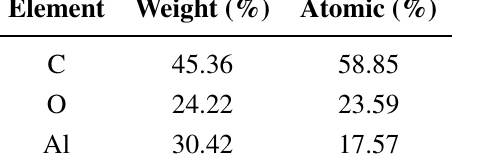
Figure 8. The EDS analysis results for 2c .